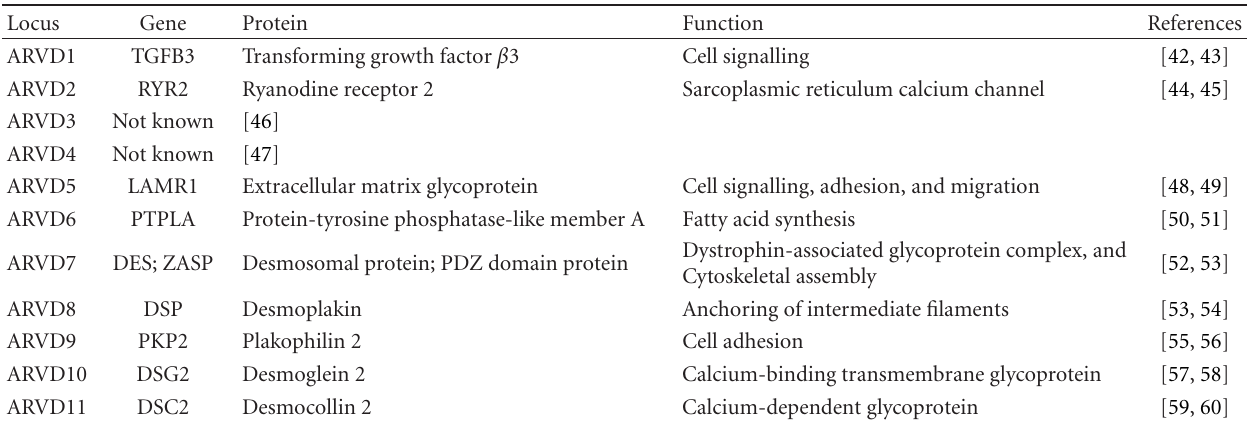
Table 4: Genes associated with